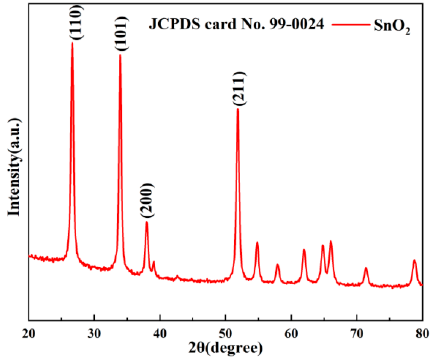
Figure 1. XRD patterns of SnO 2 nanoparticles.